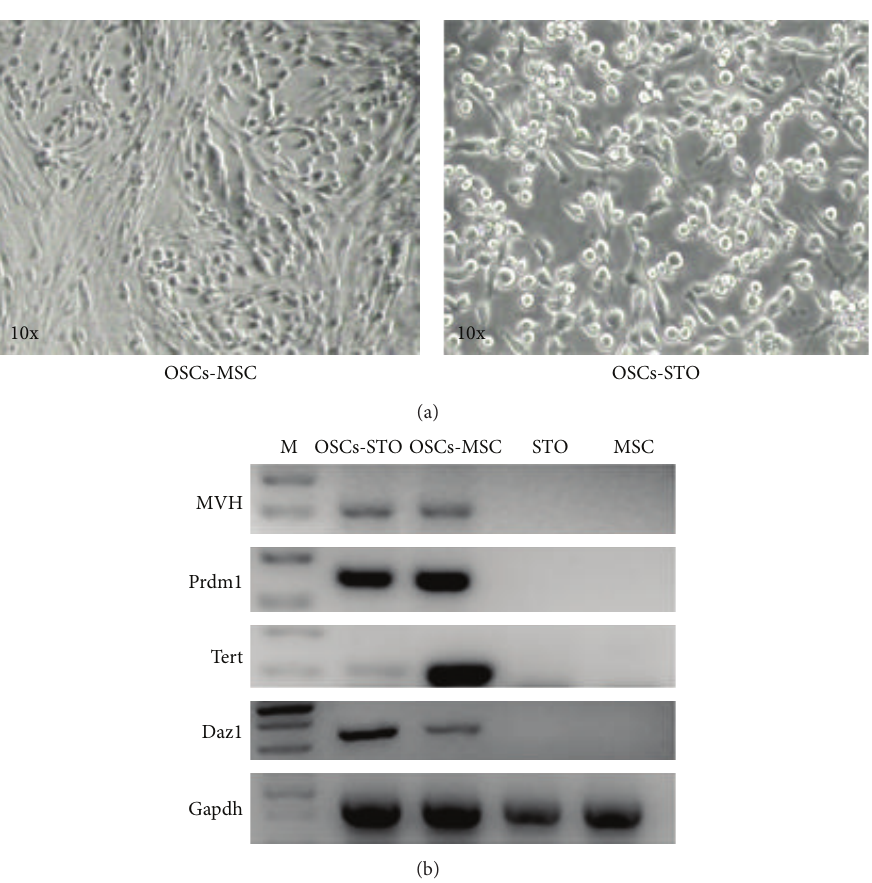
Figure 4: Comparison of STO and hUC-MSCs as feeder cells. (a) Morphological overview showed that OSCs cultured on the hUC-MSCs represented nest-like colonies (left), as compared to the typical cluster-like structures on STO (right). (b) RT-PCR analysis for gene expression profiles of OSCs cultured on STO and hUC-MSCs. The results displayed that, compared to STO feeder, OSCs on hUC-MSCs still retained the germ cell markers. STO and MSC, the negative controls for